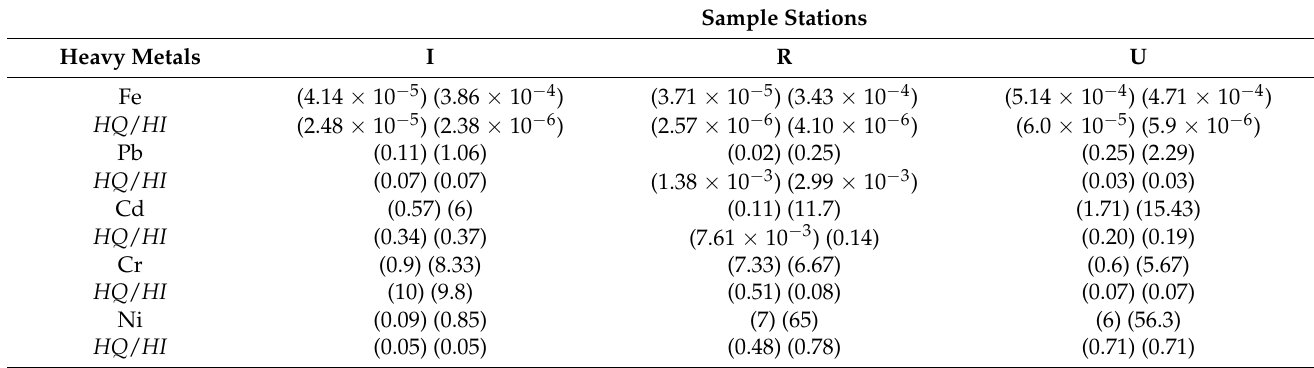
Table 7. Hazard Quotient ( HQ ) for Vernonia Amygdalina in both adults and children), respectively. Sample Stations